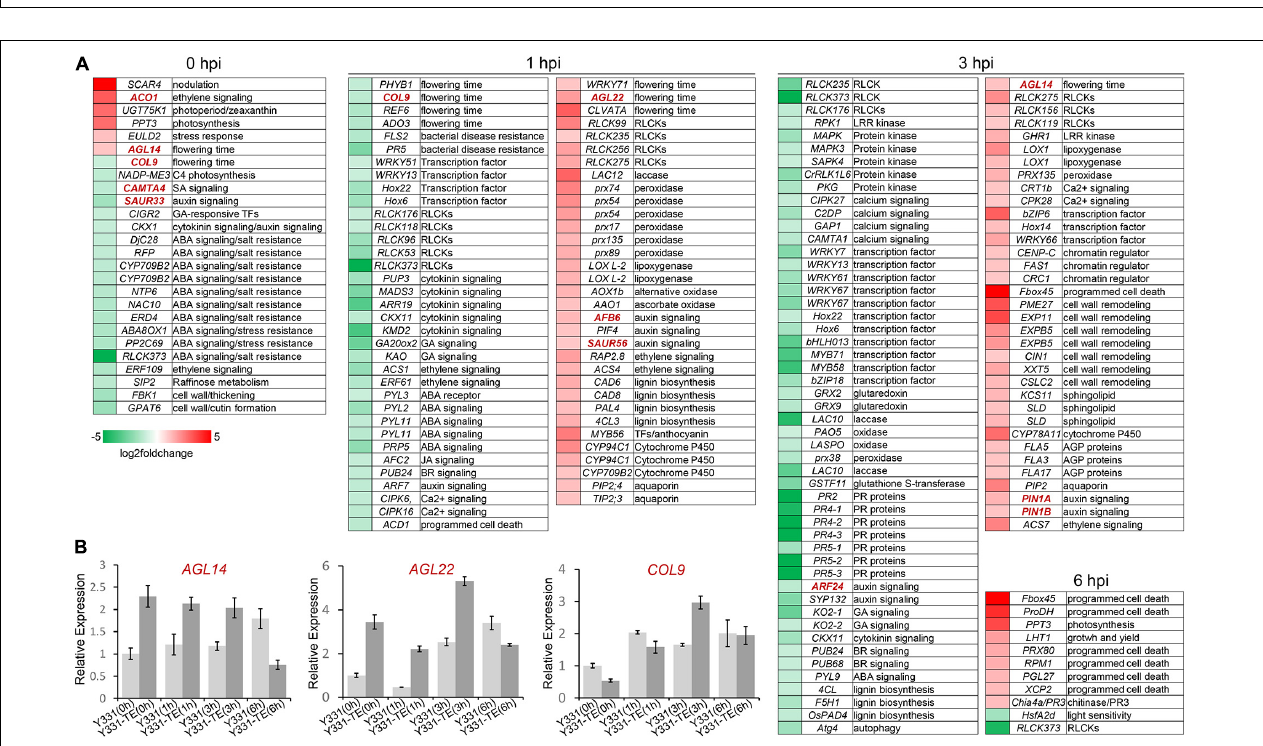
FIGURE 3 | Weighted correlation network analysis (WGCNA) analysis defined nine co-expressed genes as modules during infection stages. (A) The plots showing relative expression as TPM values of hub genes representing nine coexpressed genes modules derived from WGCNA analysis using all samples. (B) A dot plot showing the significance of KEGG pathways enriched by each coexpression module.